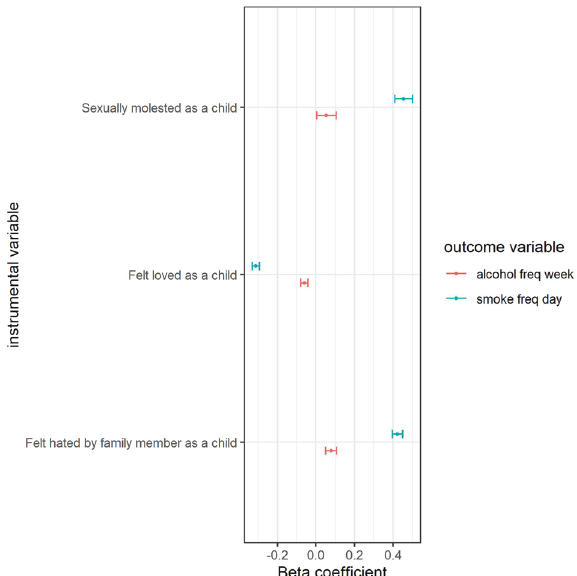
Fig. 1 Association between traumatic events during childhood and substance use in UK Biobank population. *The x -axis refers to beta coef fi cient (B). The y -axis represents the instrumental variables. Points display the B and 95% CIs (error bars) of B. Detail information was showed in Supplementary Table 1.